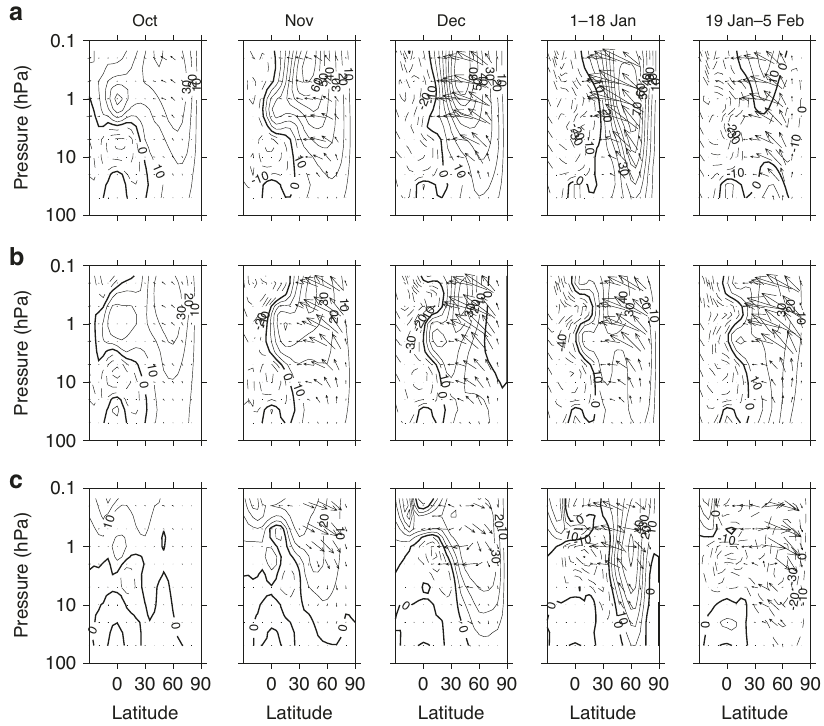
Fig. 3 Background wind and wave propagation diagnostics. Pressure (hPa) versus latitude plots (30 o S to 90 o N) of the simulated 2008/9 Eliassen – Palm (E – P) fl ux arrows (m 2 s − 2 ) to indicate wave propagation. Contours show the zonally averaged zonal winds (ms − 1 ) with a contour interval of 10 ms − 1 . Dashed contours denote negative (easterly) winds. The combination of E – P fl uxes and background zonal winds allows an examination of the wave mean- fl ow evolution and interaction during the winter (see Supplementary Fig. 4 for the corresponding distributions of E – P fl ux divergence that provide an indication of the wave mean- fl ow momentum transfer). Monthly averaged fi elds are shown for October – December leading up to the sudden warming, while the fi elds averaged over the periods 1 – 18 January and 19 January – 5 February show distributions immediately before and after the SSW event occurred. a shows the AllTrop-UpStrat-Eq experiment that was successful in reproducing the observed SSW event, in which the winds and temperatures from the surface to the tropopause were relaxed towards the European Centre Reanalysis (ERA-Interim) data at all latitudes and additionally the zonal winds in the upper equatorial stratosphere between 0 and 10 o N above 5 hPa were relaxed towards ERA-Interim data. Note that the AllTrop-UpStrat-Eq equatorial zonal winds above 5 hPa are identical to ERA-Interim, by design. b shows the AllTrop experiment that failed to correctly reproduce the timing of the SSW event, in which only the winds and temperatures from the surface to the tropopause were relaxed towards the ERA-Interim data at all latitudes. c shows the difference between the two experiments (AllTrop-UpStrat-Eq minus